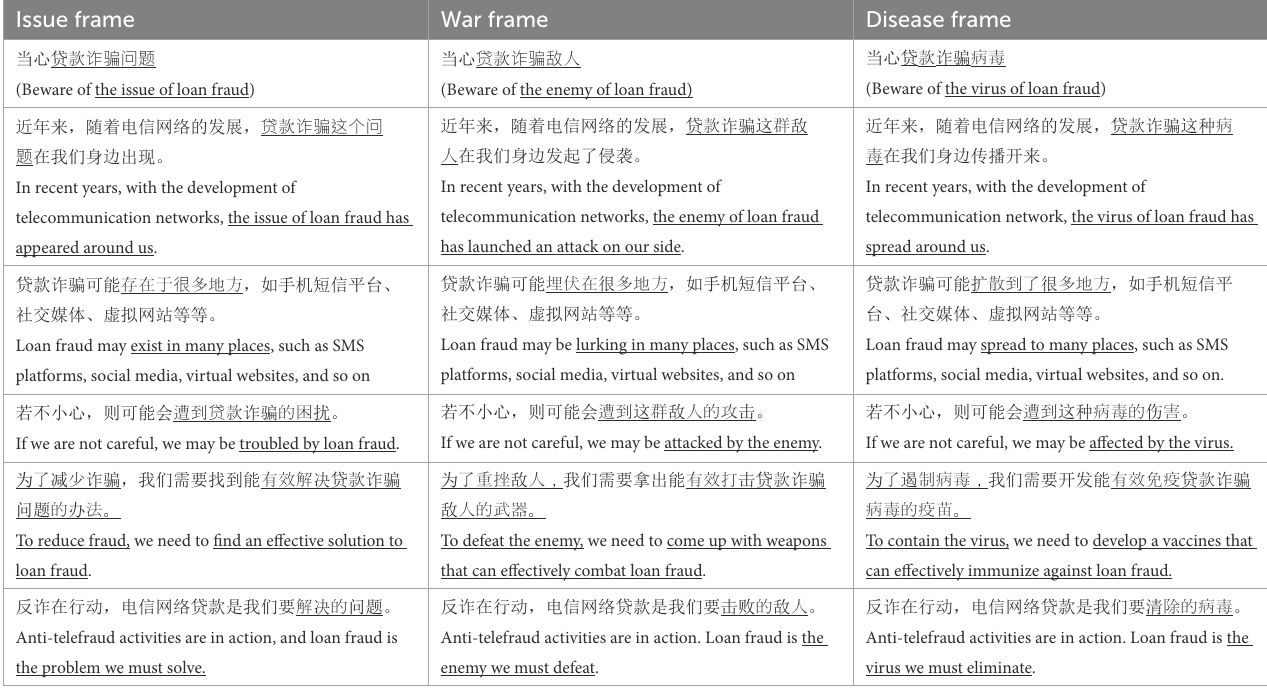
TABLE 1 Illustrative language manipulations with translations in Experiment 1 (Differences across conditions are underlined). Issue frame War frame Disease